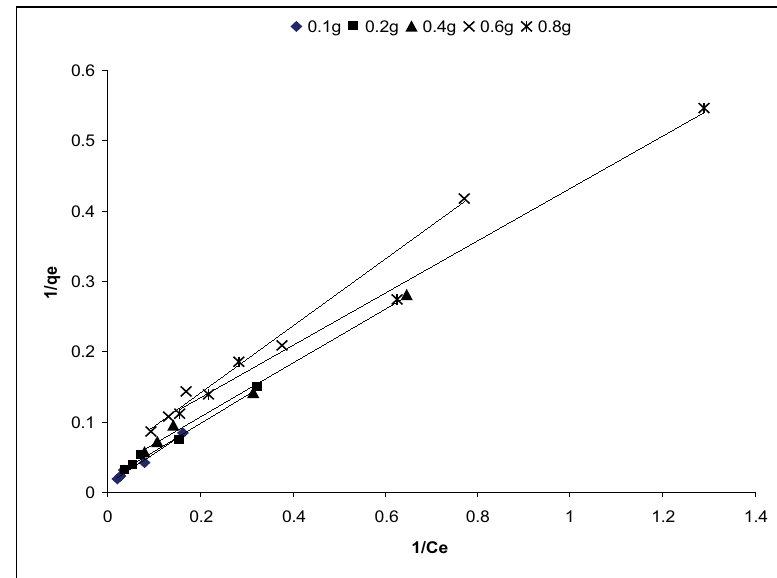
Figure 1. Langmuir isotherm plots for the sorption of CR at different PKC dosages